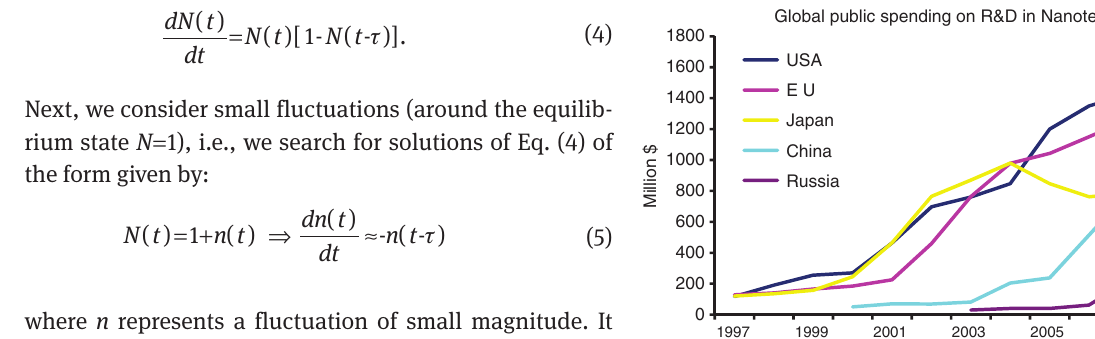
detailed data are included in the Appendix.] The fitting of